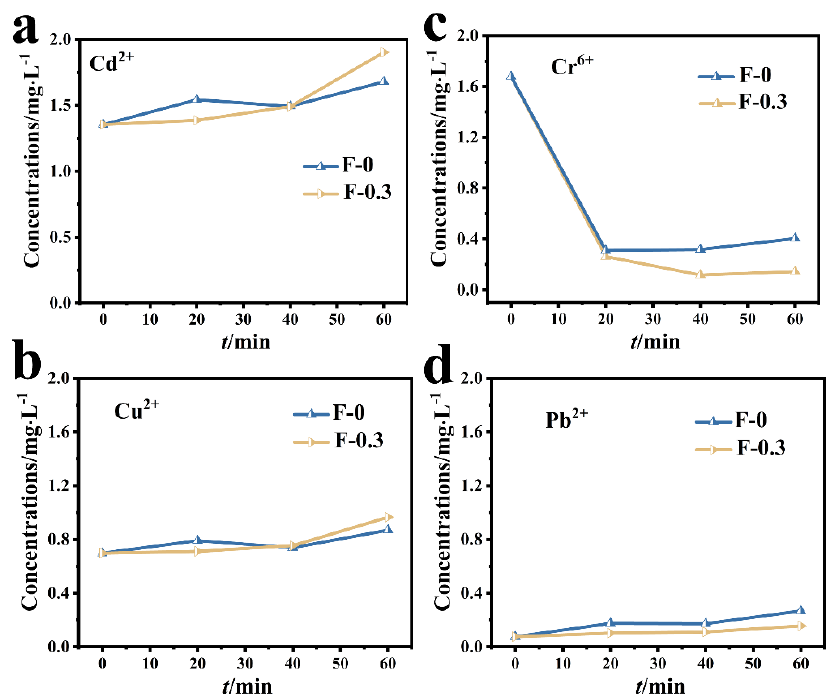
Figure 4. ( a ) Changes in the concentration of Cd ( П ) in the mixed solution; ( b ) changes in the concentration of Cu ( П ) in the mixed solution; ( c ) changes in the concentration of Cr (VI) in the mixed solution; ( d ) changes in the concentration of Pb ( П ) in the mixed solution.